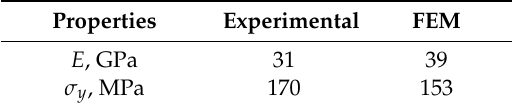
Table 4. Prediction of mechanical properties for the case of study corresponding to a porous compact fabricated by 40 vol.% NH 4 HCO 3 space holder.